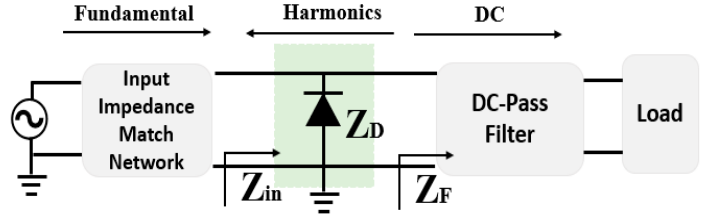
Figure 1. The block diagram of the proposed rectifier.